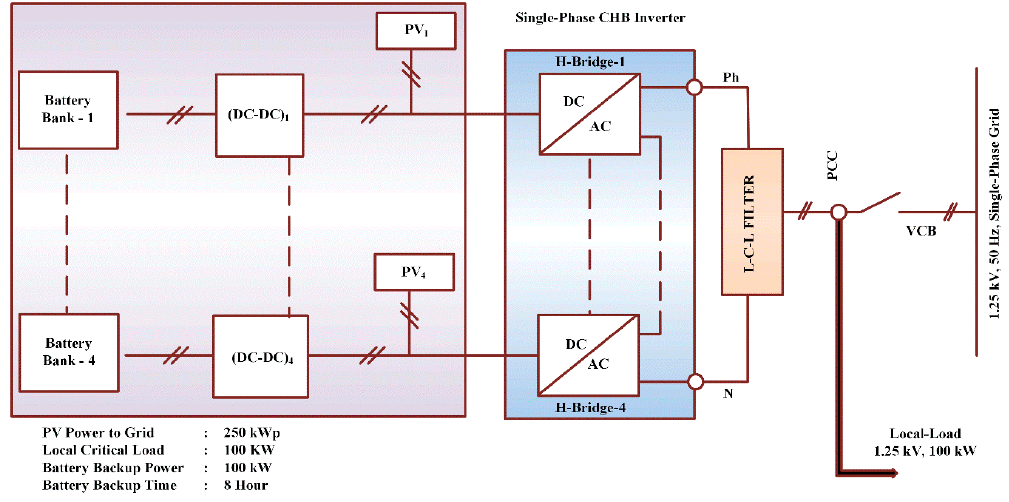
Figure 3. DC-coupled ESS for CHB-based PCS.